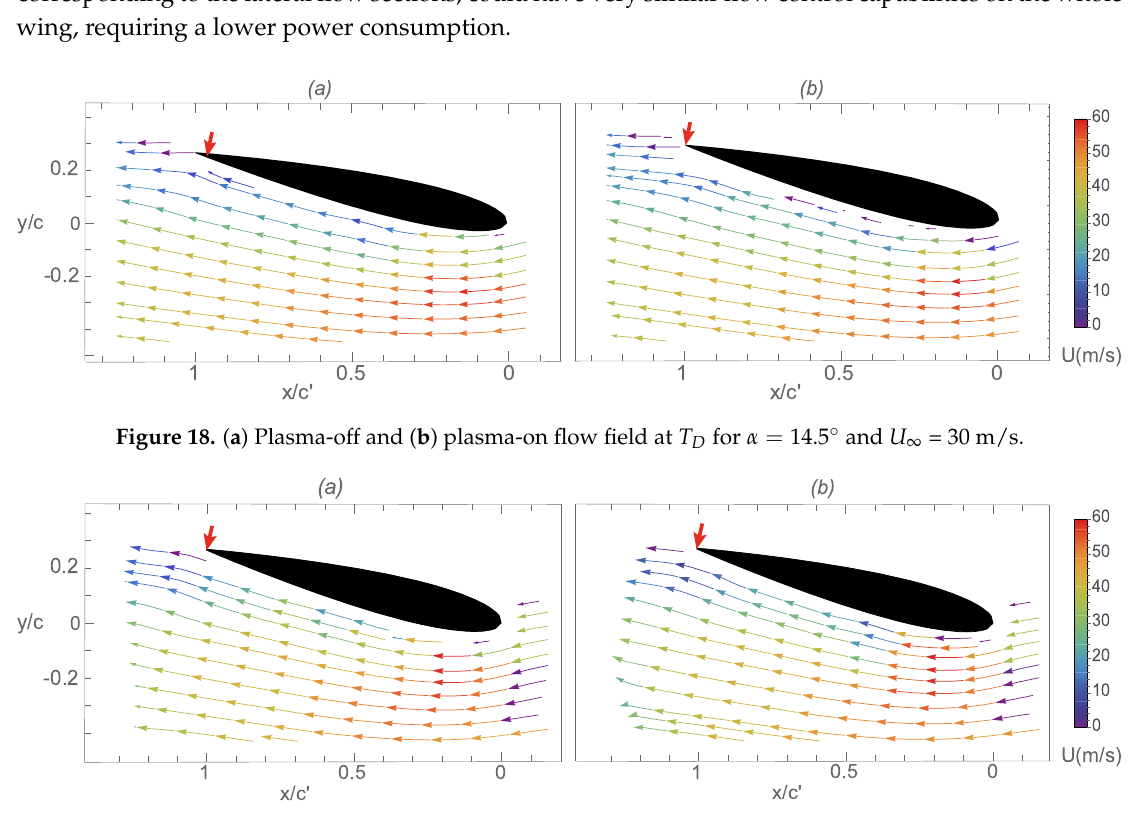
Figure 19. ( a ) Plasma-off and ( b ) plasma-on flow field at T E for α = 14.5 ◦ and U ∞ = 30